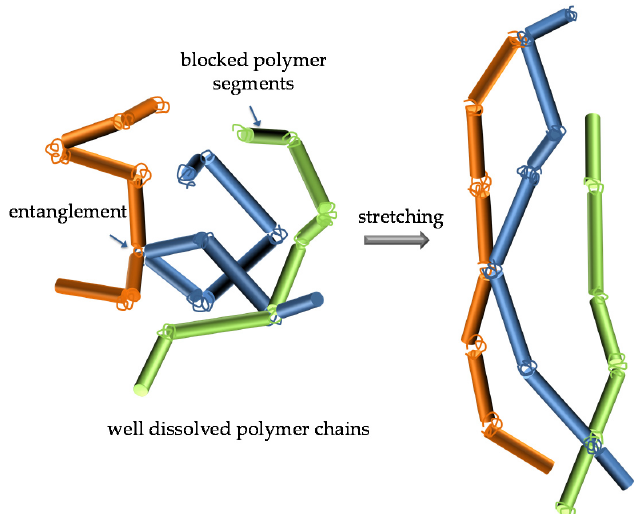
Figure 1. ( a ) Inverted tube test and ( b ) dimensional stability of PEO50-2.5/U150 and ( c ) elastomeric character of PEO9-5/U150.